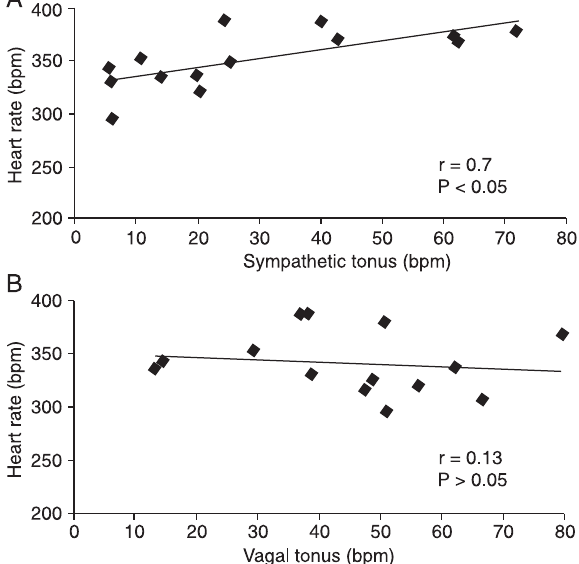
Figure 1. Correlations between (A) resting heart rate and sympa - thetic tonus (P < 0.05) and (B) resting heart rate and vagal tonus for both sedentary and trained rats. Correlations were determined by linear regression analysis.